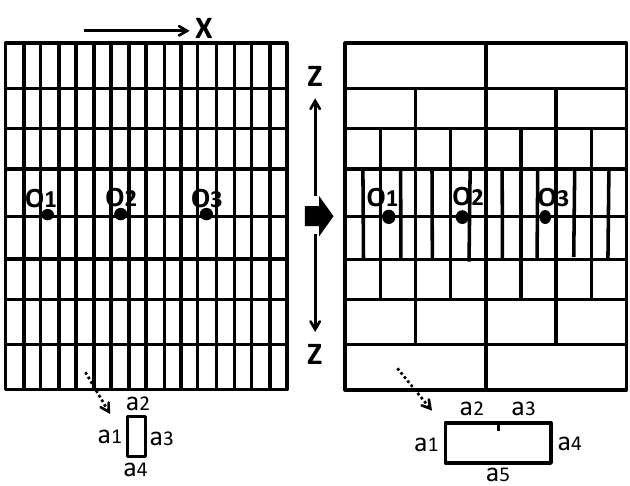
Figure 1 . The sketch of the scale transformation and the correlation function. The left and right picture corresponds to the path-integral representation of correlation function before and after the optimization, respectively. A tensor is attached on the face of each of these cells. In the left picture there are tensor with 4 legs ( T a ) attached on the faces of the cells. After the coarse 1 ;a 2 ;a 3 a 4 graining procedure these tensors are replaced by some e(cid:11)ective tensors ( T a ) as shown in 1 ;a 2 ;a 3 ;a 4 ;a 5 the right